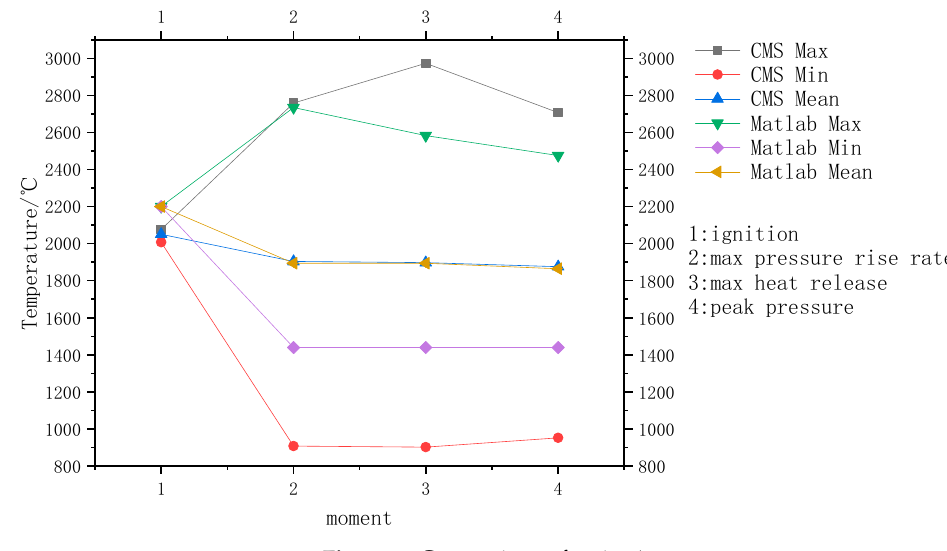
Figure 8. Comparison of series 1. Table 5. Error of typical temperature based on CMS of series 1.